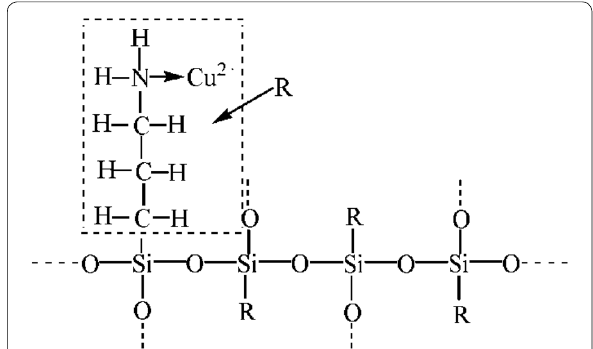
Fig. 4 Scheme showing an amino-functionalized silica anchoring copper(II)